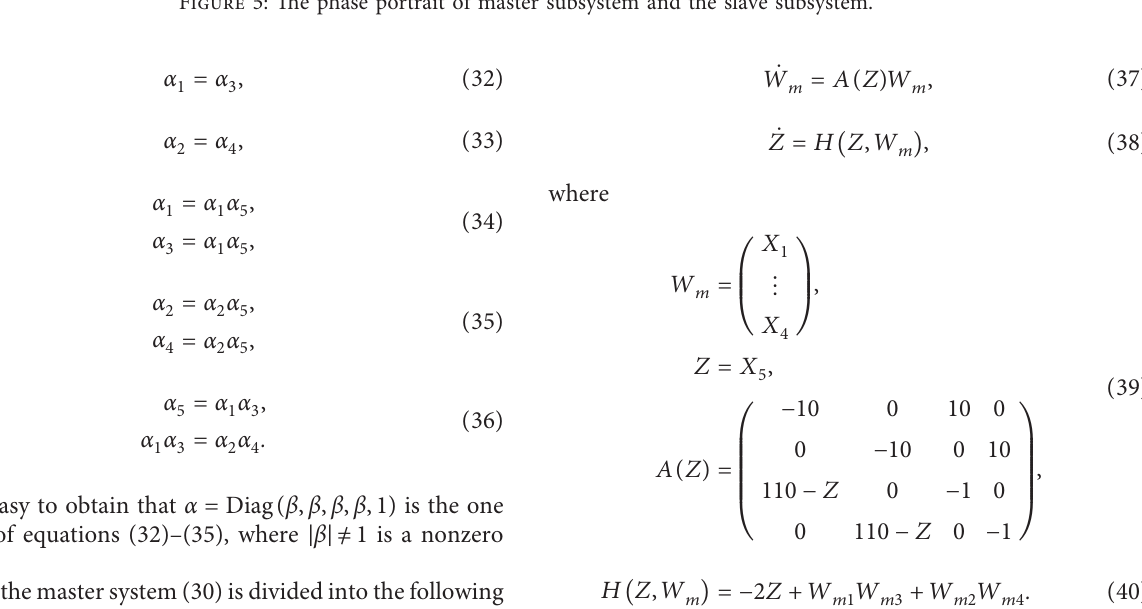
Figure 5: The phase portrait of master subsystem and the slave